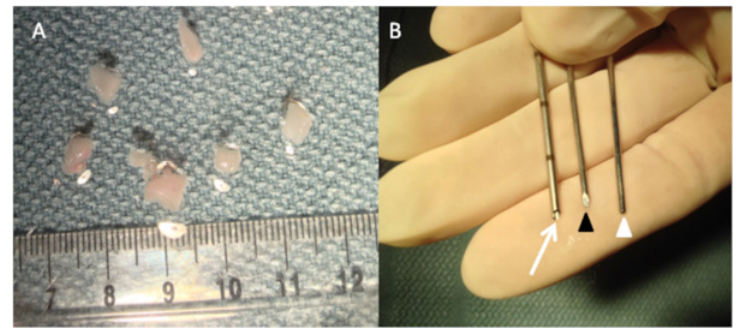
Fig 1. Tumor preparation. (A) Hind limb tumors were placed in a sterile petri dish and sliced into small tumor fragments (3-4mm 3 ). (B) A 17 gauge coaxial introducer has a hollow core (white arrow), with two inner stylets, sharp (black arrow head) and blunt (white arrow